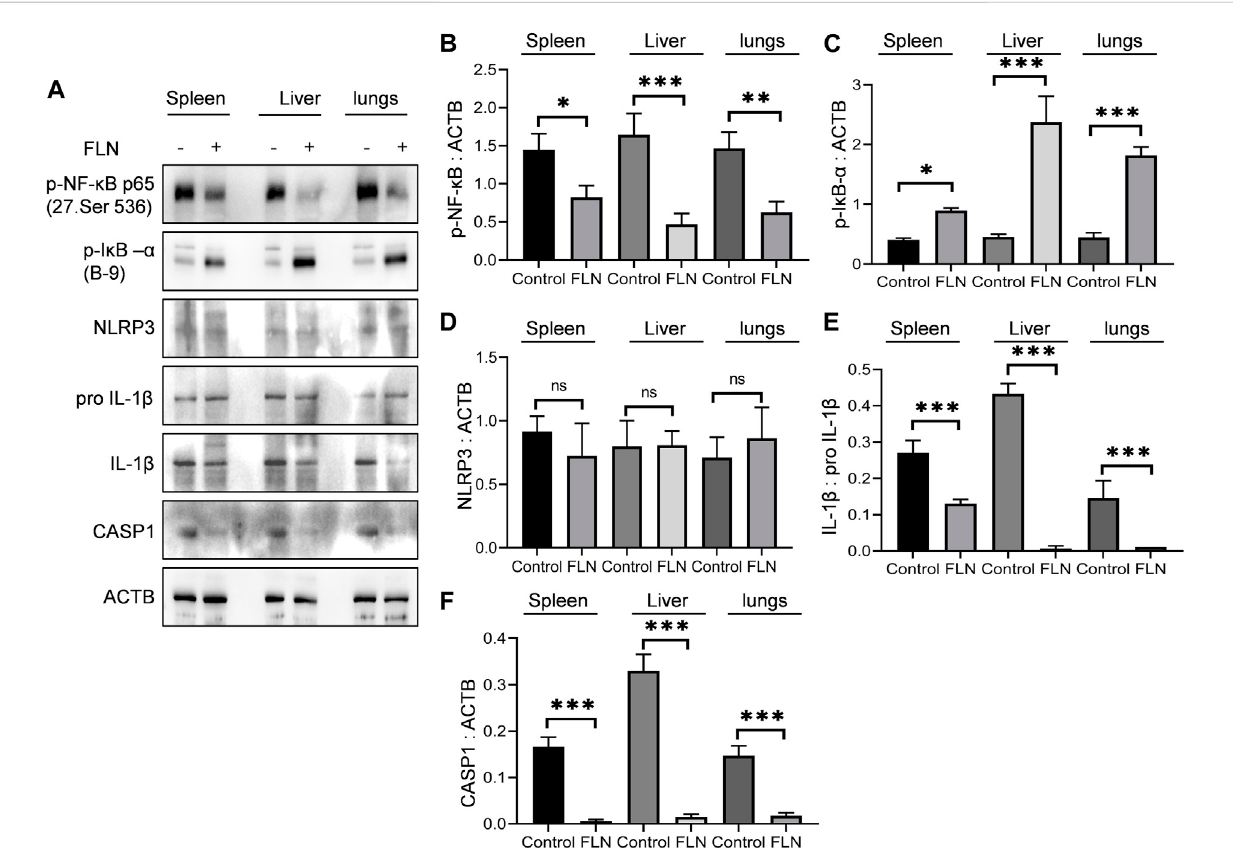
FLNprotectstheorgansfromin fl ammatorydamageinSCD.Post-dosingofFLNinBerkeleymice,lysateswerepreparedbyhomogenizing tissuesin RIPA buffer. (A) Immunoblots of in fl ammatory proteins in spleen, liver and lungs of Berkeley mice. Densitometry analysis of immunoblots given in Figure 8A; (B) p-NF- κ B, (C) p-I κ B- α , (D) NLRP3, (E) IL-1 β , and (F) CASP1 measured using ImageJ software. ACTB was used as an internal control and for protein normalization. For cleaved IL-1 β , pro IL-1 β expression was used for normalization. One-way ANOVA analysis was done to check the statistical signi fi cance of data, and Bonferroni test was done for multiple comparisons. P < 0.05 was considered signi fi cant. p values *** p < 0.001, ** p < 0.01, * p <